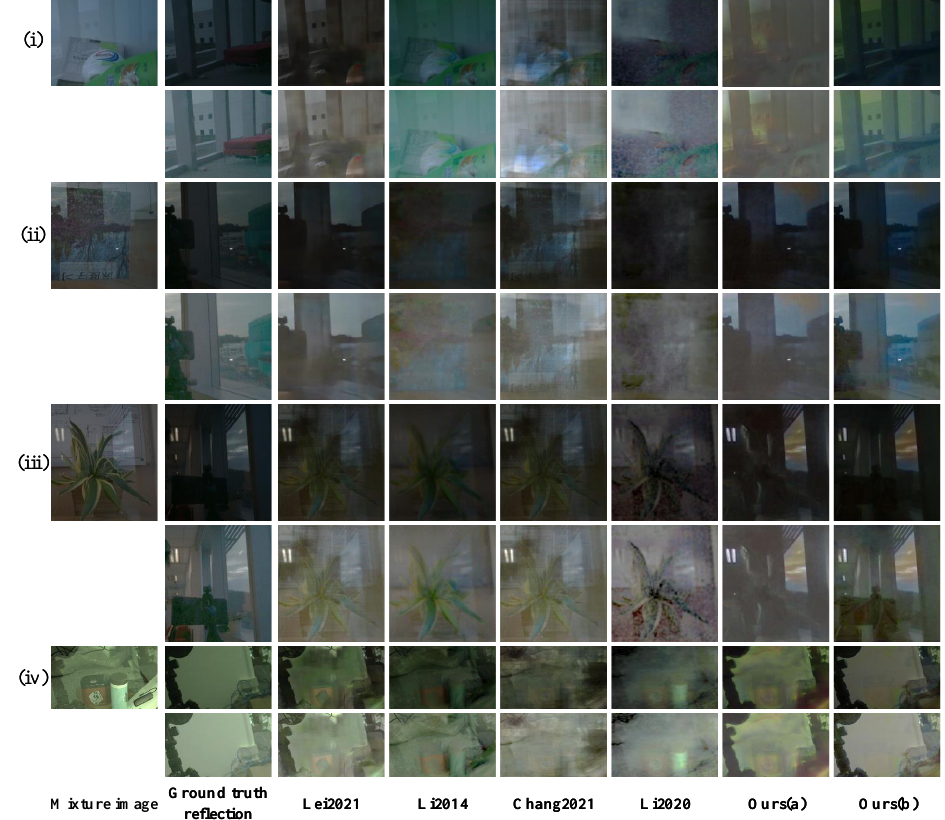
Figure 10. Qualitative comparison of the transmission removal results on real-world mixture images. ( i )–( iv ) correspond to four different test images. For each test image, the first row and second row are the direct outputs of all methods and their corresponding histogram equalized versions. Lei2021: [13], Li2014: [14], Chang2021: [16], Li2020: [17]. Table 3. Training time of the proposed network and other networks Training Time